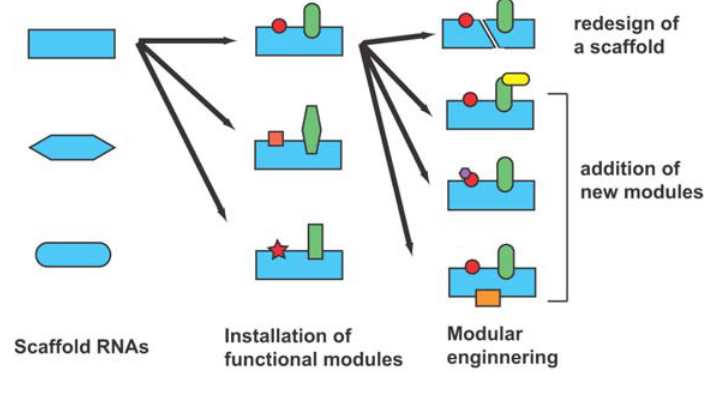
Figure 2. Schematic representation of the design and selection strategy for generation of novel functional